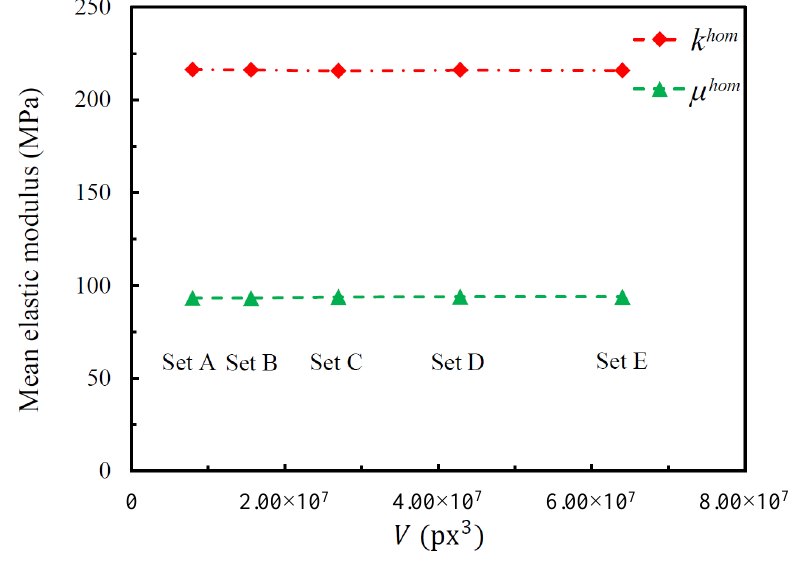
Figure 10. Evolution of k hom and µ hom as a function of the RVE